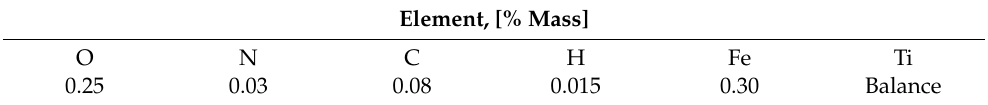
Table 1. Chemical composition of technically pure titanium 99.2 according to ASTM 8348. Element, [%